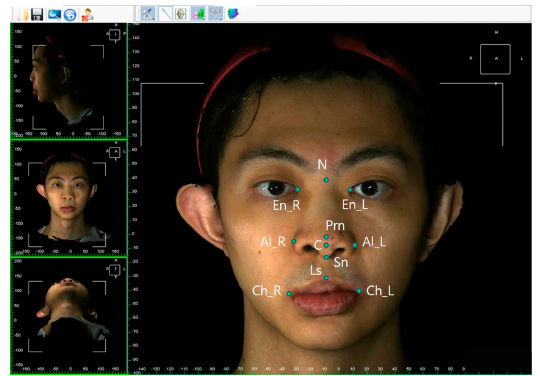
Figure 1. Three-dimensional imaging of a patient with bilateral cleft lip nose deformity at maturity showing anatomical landmarks: R, right; L, left; N, nasion; En, endocanthion; Prn, pronasale; C, columellar constructed point; Sn, subnasale; Al, alare; Ls, labiale superius; Ch, cheilion.